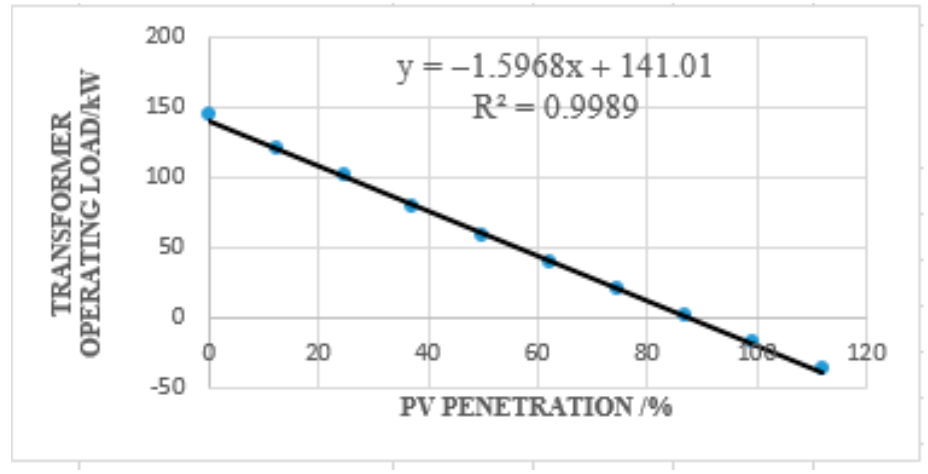
Figure 5. Graphical analysis of transformer kW loading.